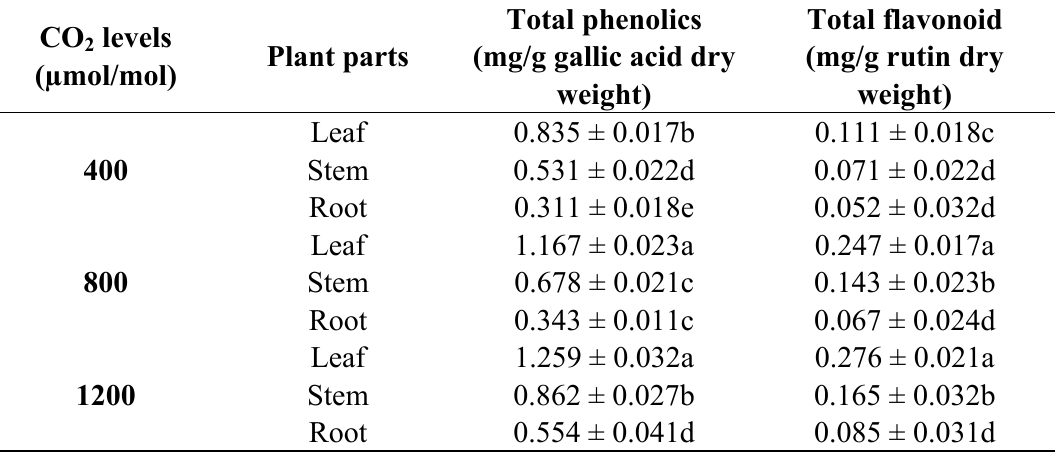
Table 1. Total phenolics and flavonoids contents in different parts of L. pumila under different CO 2